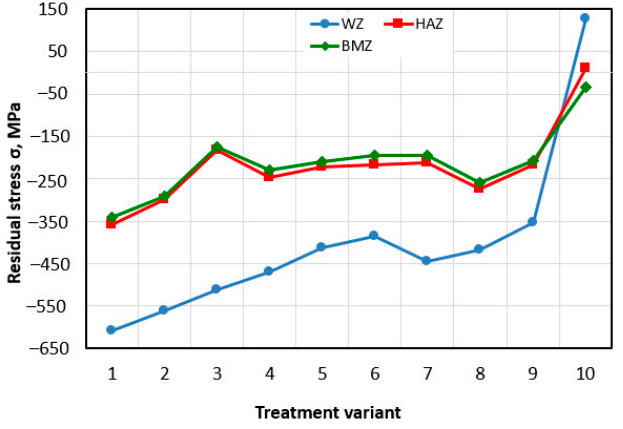
Figure 6. Effect of treatment variant on the value of residual